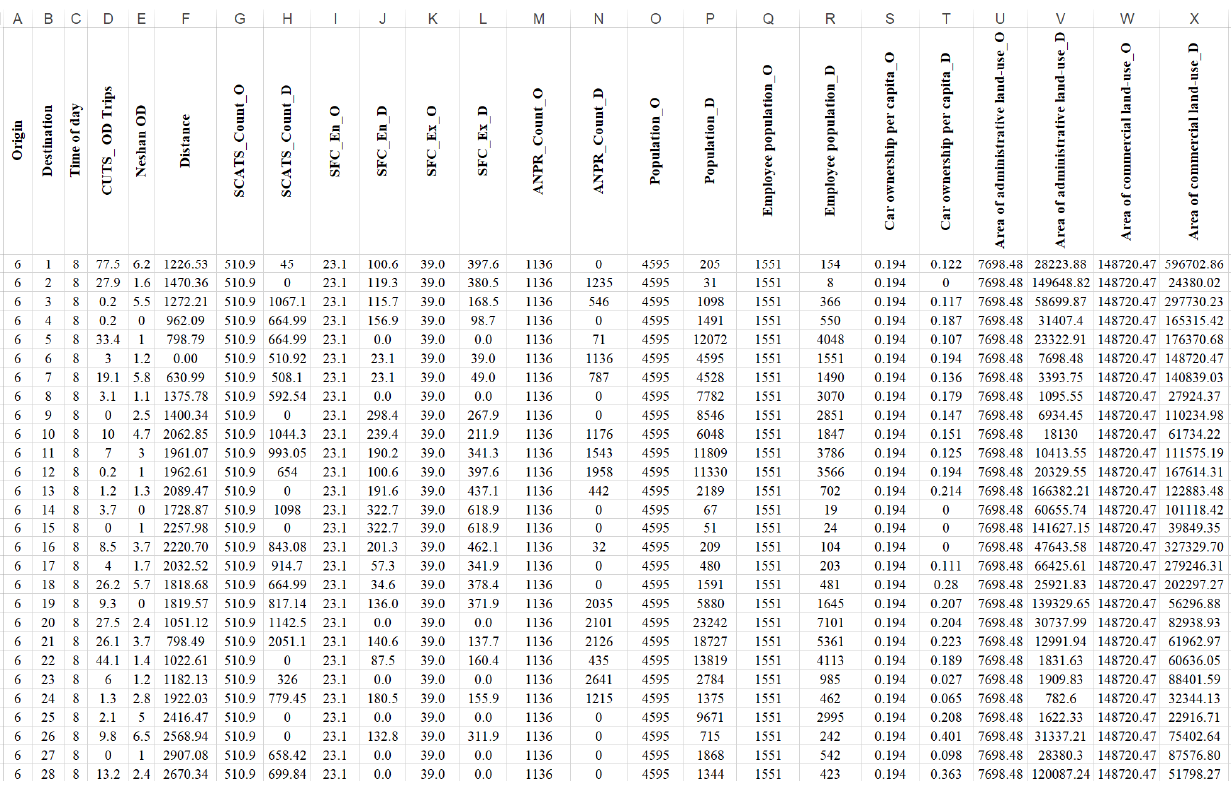
Figure 6. A sample snapshot of source data.